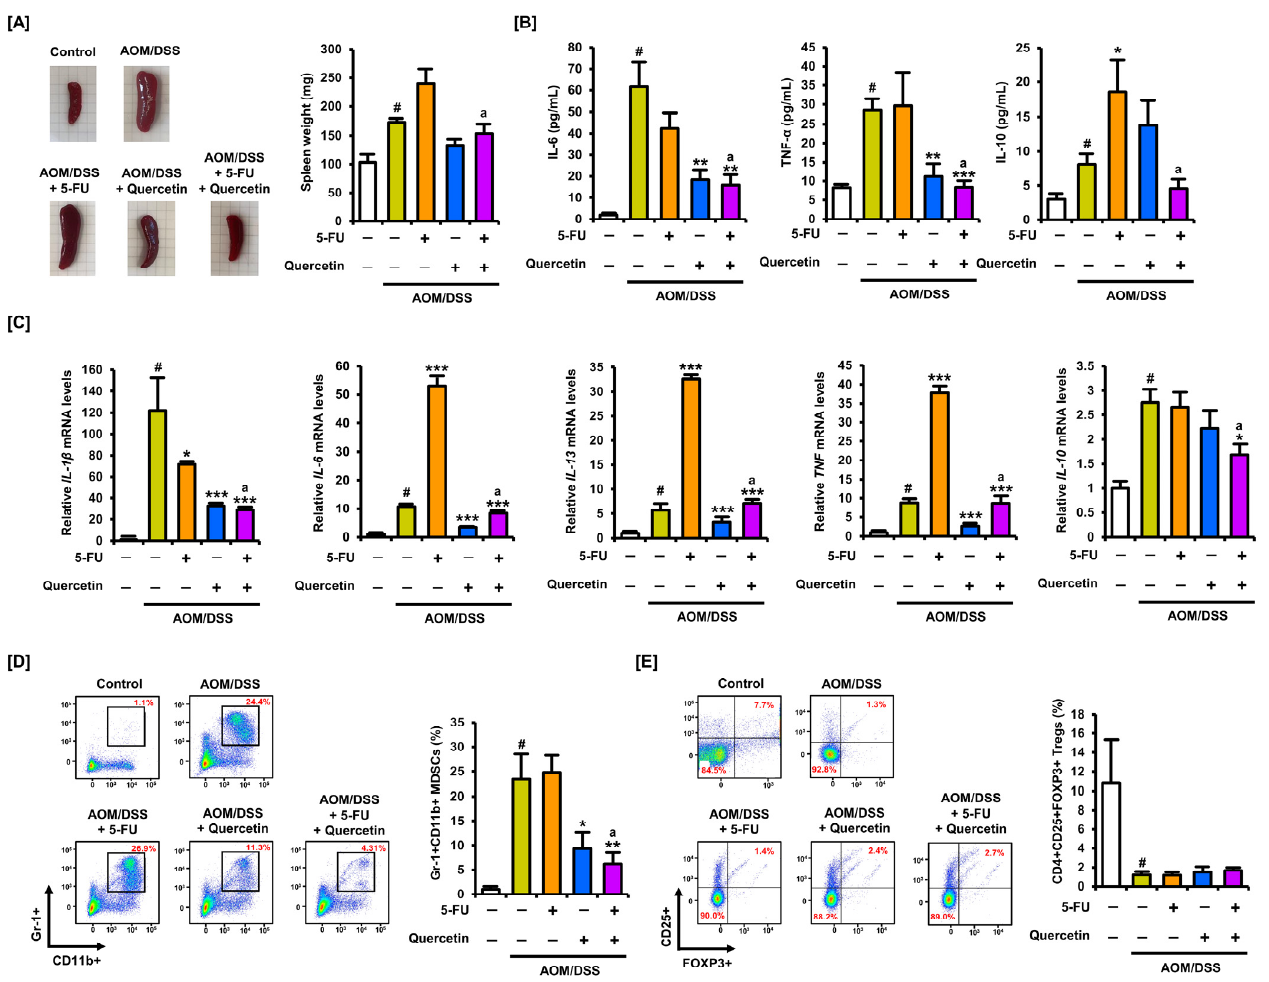
Figure 8. Quercetin ameliorated 5-FU-induced increases in inflammatory cytokines and increases in myeloid-derived suppressor cells (MDSCs) in CRC mice. ( A ) Spleen images following administra- tion of 5-FU and quercetin in CRC mice are presented. (B) Concentration changes in IL-6, TNF- α , and IL-10 following administration of 5-FU and quercetin in the serum of CRC mice were analyzed by ELISA. ( C ) Changes in mRNA expression levels of IL-1 β , IL-6, IL-13, TNF, and IL-10 following administration of 5-FU and quercetin in distal colon of CRC mice were analyzed by qPCR. ( D ) The proportion of MDSCs positive for Gr-1 and CD11b in the spleen of CRC mice was determined by flow cytometry. ( E ) The proportion of Tregs positive for CD4, CD25, and FOXP3 in the spleen of CRC mice was determined by flow cytometry. Data are presented as representatives of the results of three independent experiments. Asterisks indicate statistically significant differences compared with untreated AOM/DSS controls (*** p < 0.001; ** p < 0.01; * p < 0.05). The symbol ‘#’ indicates a significant difference between normal and AOM/DSS controls ( p < 0.05). The symbol ‘a’ indicates a significant difference between combination treatment and 5-FU treatment alone ( p < 0.05). 4. Discussion The most common chemotherapeutic agent used for the treatment of CRC is 5-FU, and it functions by irreversibly inhibiting TS, causing DNA damage [23]. It is well-known that inhibition of TS activity causes antiproliferative effects accompanied by cell cycle ar- rest [24]. A previous study revealed that quercetin could inhibit TS, regulate the cell cycle, and induce apoptosis in oral cancer cells [25]. As previously reported, 5-FU increases the expression levels of both bound and unbound TS in CRC cells, presumably in a feedback loop to protect cells from drugs that inhibit TS activity [26]. In this study, quercetin inhib- ited the expression of TS in CRC cells and enhanced their sensitivity to 5-FU. The changes